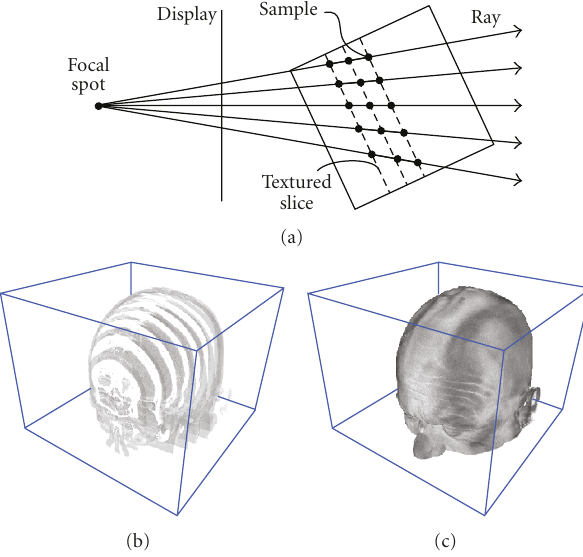
Figure 7: (a) Volume rendering involves the evaluation of the volume render equation along the rays, passing through the pixels of the display. The usage of textured slices means that the rays are not evaluated sequentially. Rather for a single slice the contribution of the sample points to all rays is processed. (b) A volume rendered data set, with large intervals between the textured slices. (c) The same volume rendered data set, with a small distance between the textured